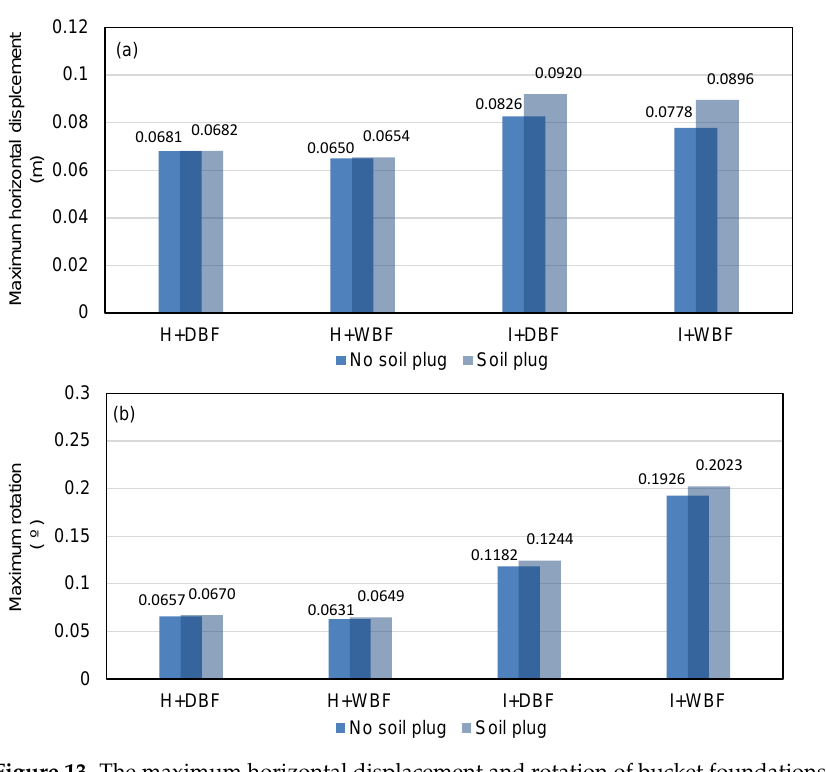
Figure 12. The settlement time histories at the left and right corner points of the wide bucket foundation (WBF) in 50% relative density inclined liquefiable seabeds.